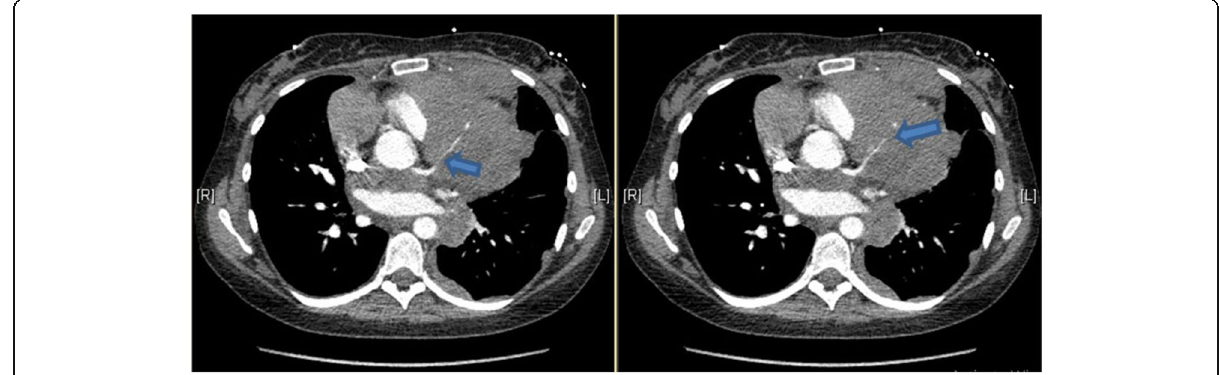
Fig. 2 CT pulmonary angiogram reveals encasement and displacement of the left anterior descending coronary artery (blue